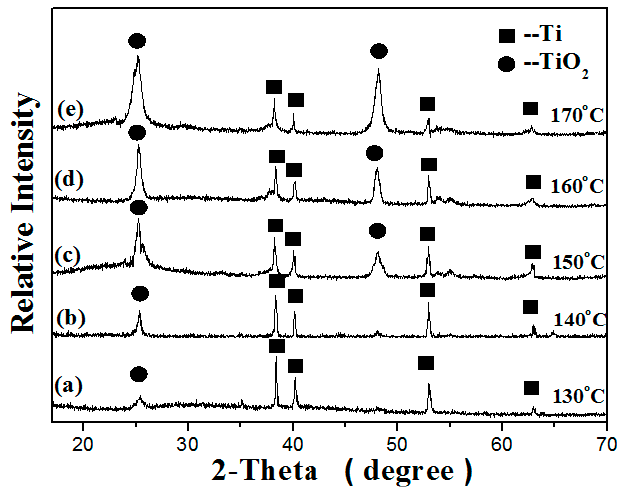
Figure 5. XRD patterns of samples prepared at different temperatures. (a) 130 °C; (b) 140 °C; (c) 150 °C; (d) 160 °C; (e) 170 °C.